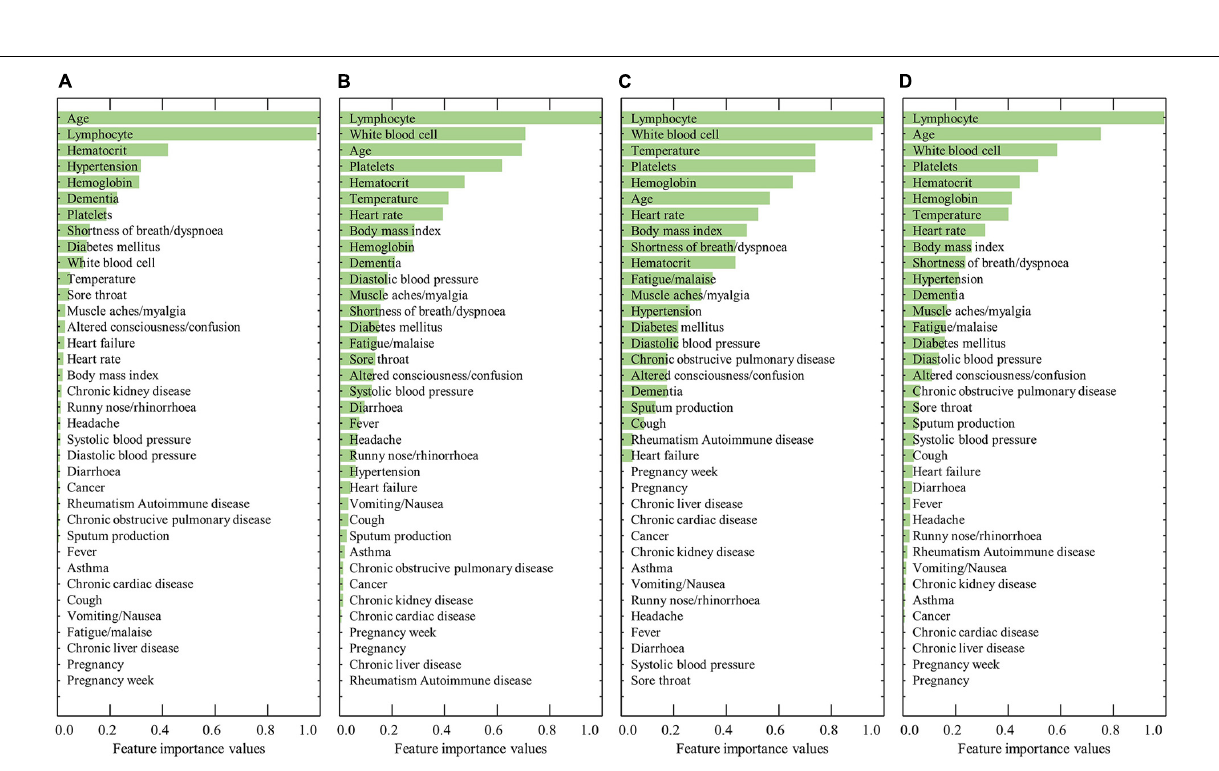
Frontiers in Physiology |